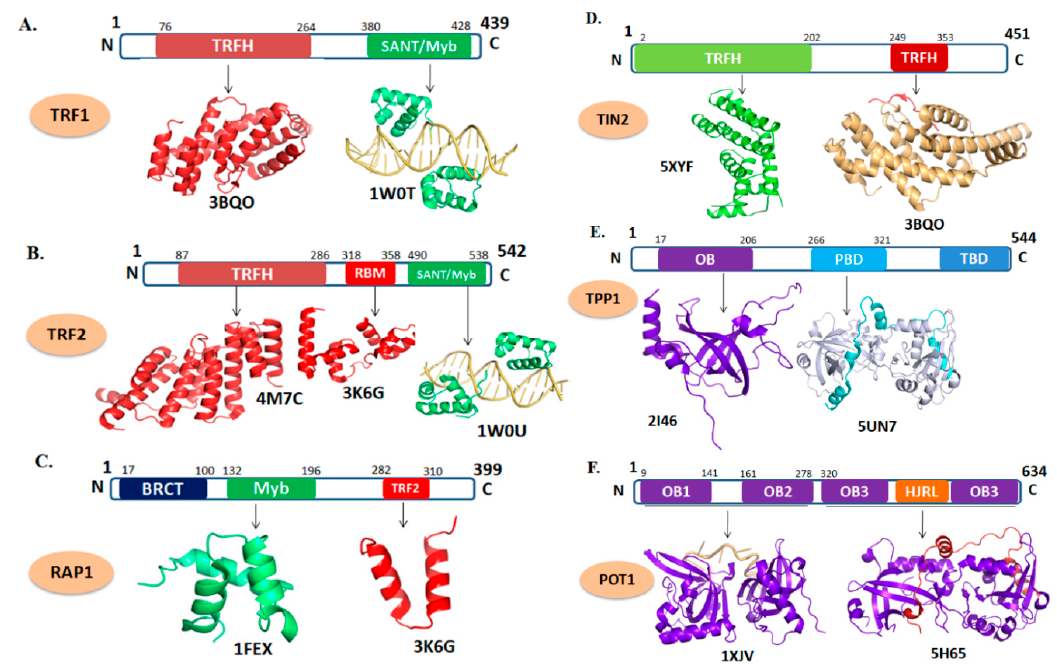
Figure 2. Domain organization and tertiary structure of the shelterin complex. ( A ) telomere repeat factor 1 (TRF1) (PDB ID: 3BQO; depicts the cartoon representation of TRF homology (TRFH) domain of TRF1 in red. 1W0T; the DNA-binding domain of TRF1 shown in green in complex with telomeric DNA which is shown as light orange). ( B ) TRF2 (PDB ID: 4M7C; represents TRFH domain of TRF2. 3K6G; represents the repressor / activator protein 1 (RAP1)–binding motif of TRF2 in red. 1W0U; represents the DNA-binding motif of TRF2). ( C ) RAP1 (PDB ID: 1FEX; represent the Myb domain shown in green and 3K6G; shows RCT domain in red). ( D ) TIN2 (PDB ID: 5XYF; cartoon representation in green depicts TRFH domain and 3BQO; TRF1-interacting nuclear factor 2 (TIN2) peptide shown in red complexed with TRFH domain of TRF1). ( E ) TPP1 (PDB ID: 2I46; depicts the OB-fold domain in purple and 5I2X; represents the POT1 interacting domain of TPP1 (cyan) with C-terminal domain of POT1 (gray)). ( F ) POT1 (PDB ID: 1XJV; depicts the C-terminal domain of POT1 in purple in complex with telomeric DNA (light orange) 5H65; represents the POT1 interacting domain of TPP1 (red) with C-terminal domain of POT1 (purple).